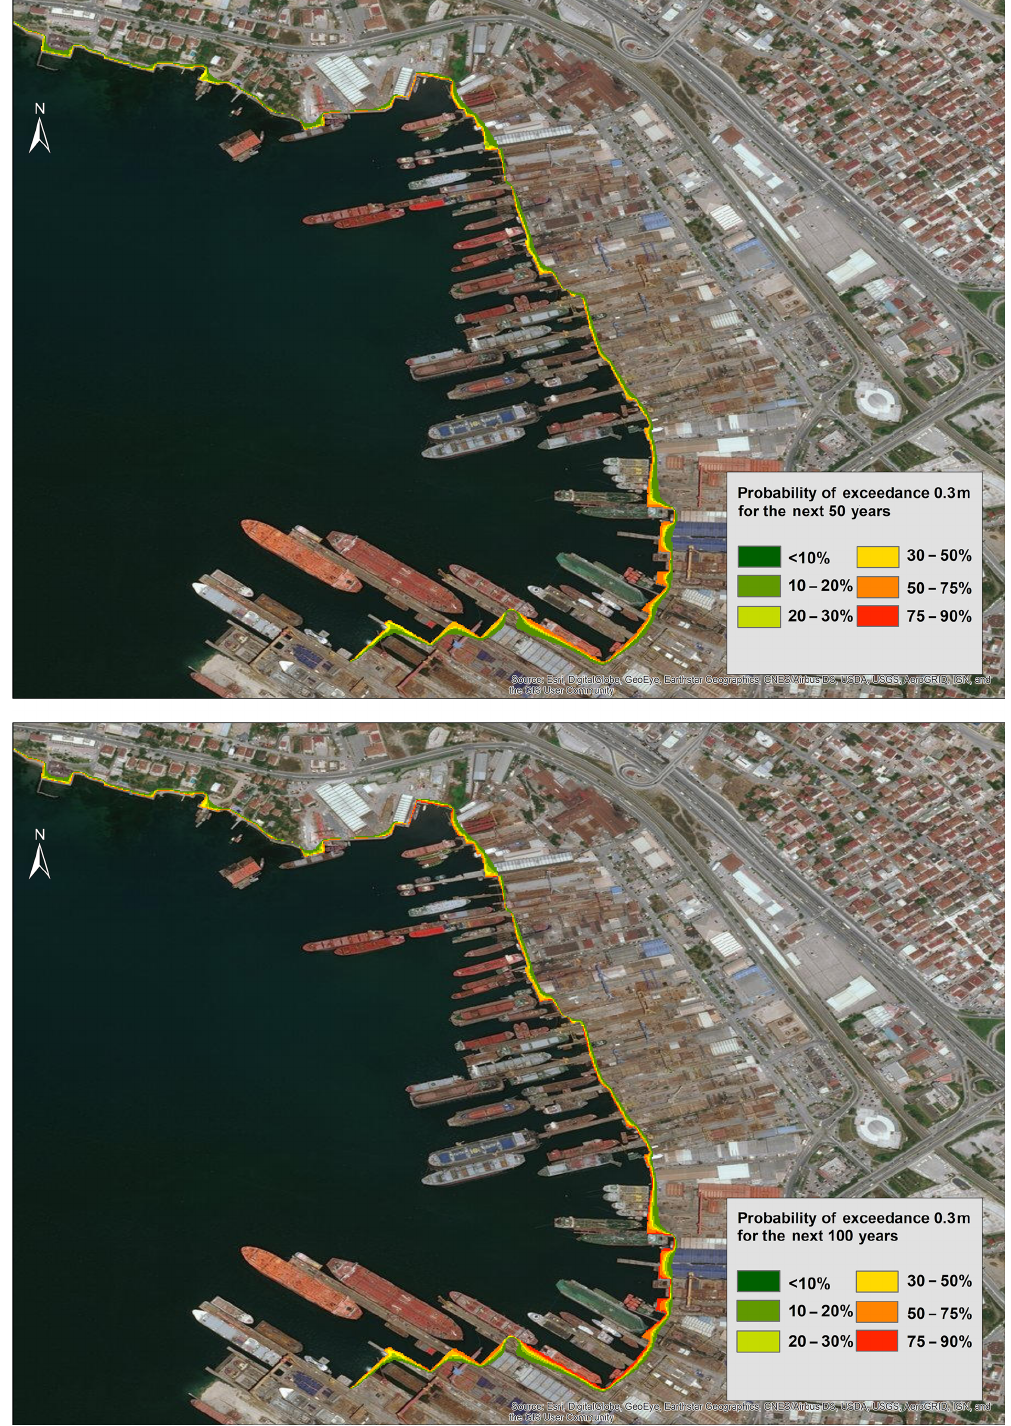
Figure 11. Probabilistic tsunami inundation maps of the shipyard area in the Tuzla study domain representing the probability of exceedance of 0.3m inundation depth for the next 50 and 100 years. Change of colors from green to red represents the increasing probability of exceedance (created using ArcMap version